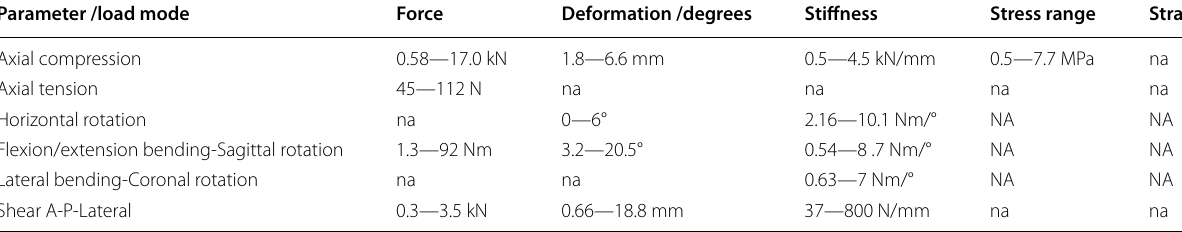
na not available, NA not applicable